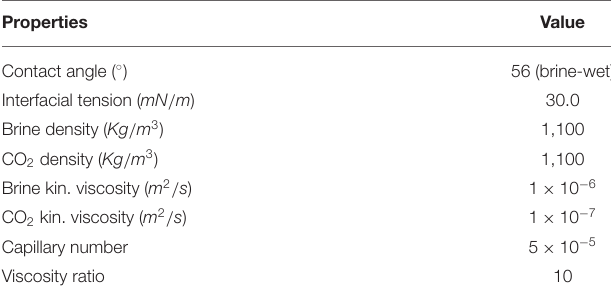
TABLE 1 | Properties of CO 2 -brine flow